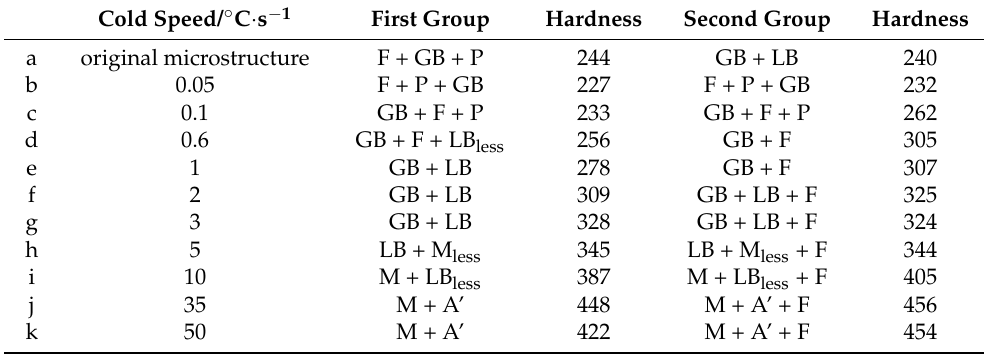
Table 2. Microstructure types and hardness values of the specimens under different cooling